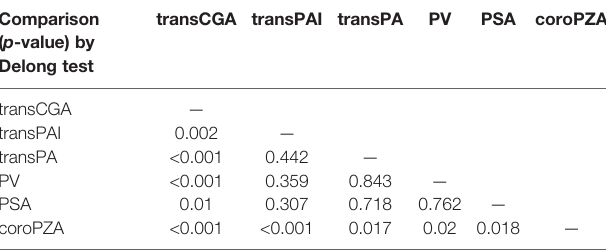
TABLE 6 | The statistical difference in AUC of predicting PCa among single predictors in the training cohort. Comparison ( p -value) by Delong